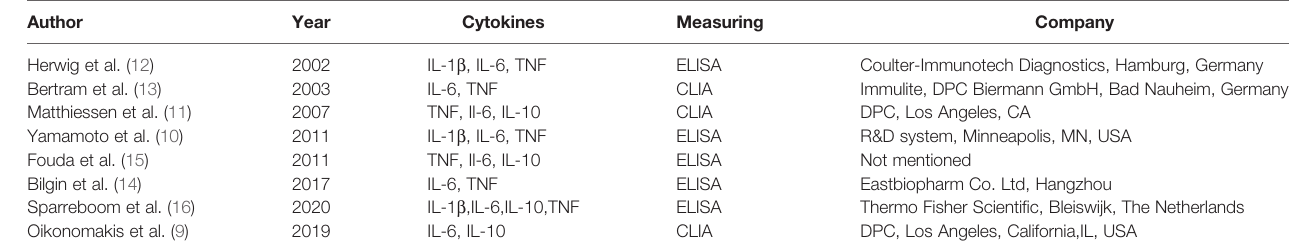
TABLE 3 | Methodology of cytokine level measurement of included studies.